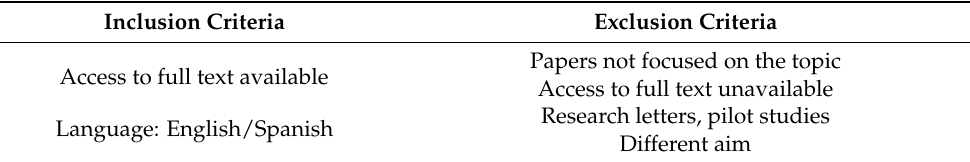
Table 1. The inclusion and exclusion criteria used to limit the results to the study object. Inclusion Criteria Exclusion